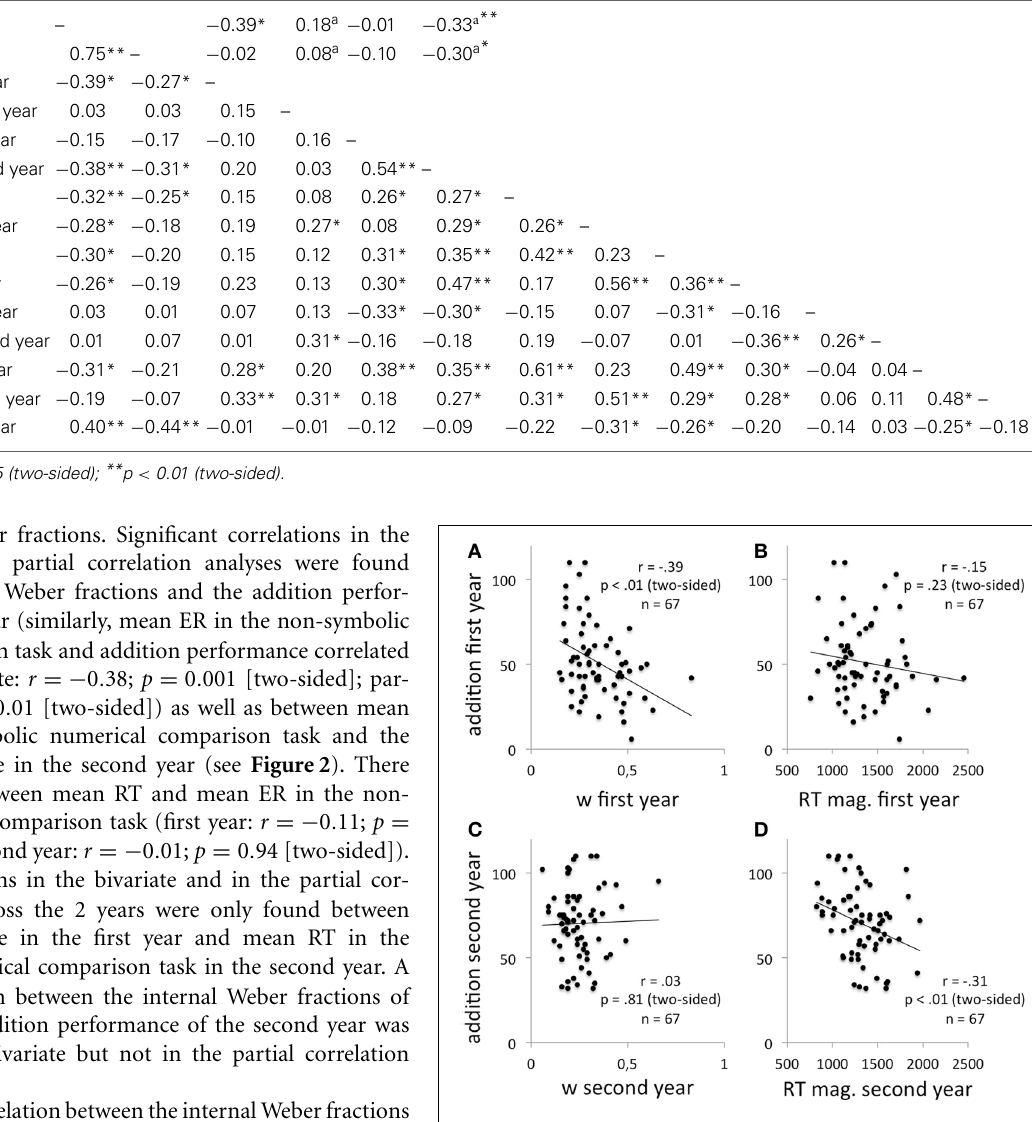
FIGURE 2 | Correlations between the internal Weber fractions and the addition performance in the first year (A) and in the second year (C) as well as correlations between mean RT in the non-symbolic numerical comparison task and the addition performance in the first year (B) and in the second year